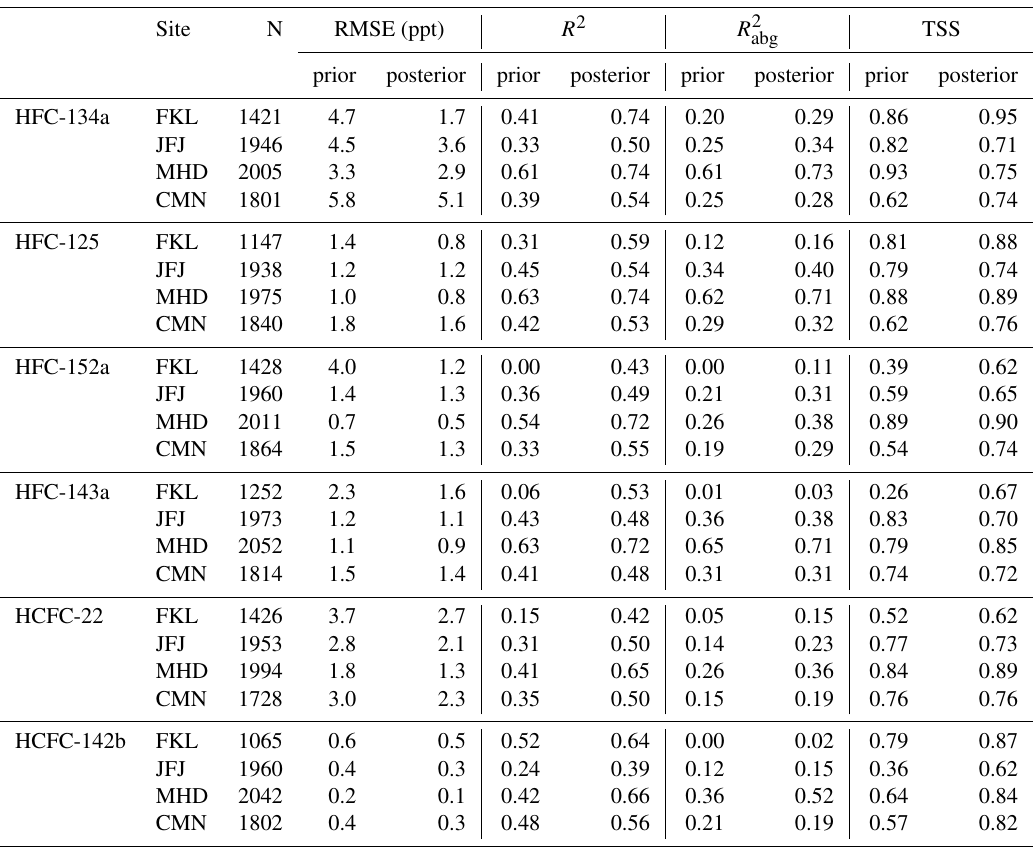
is the coefficient of determination of the signal above abg